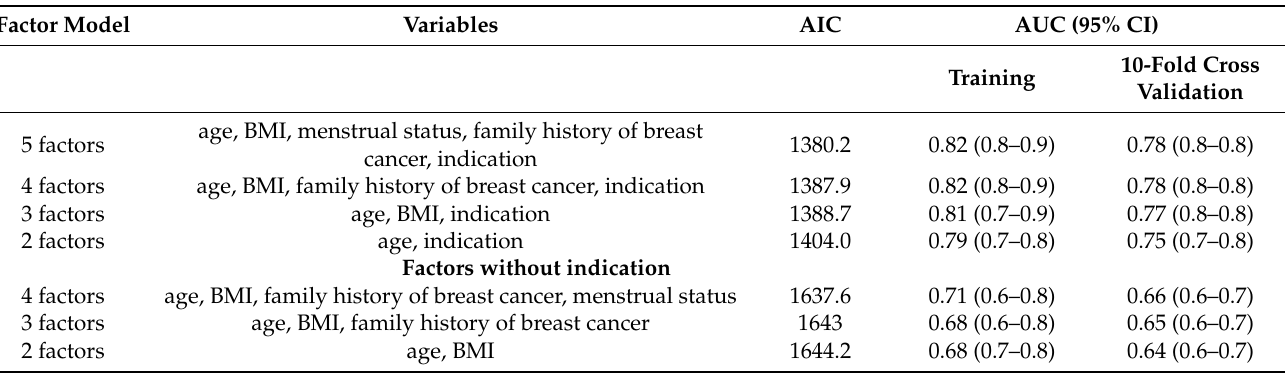
Figure 2. The 4-factor model using age ≥ 50 years, body mass index ≥ 30 kg/m 2 , history of breast cancer in the family, and symptomatic indication for mammography with an Akaike information criterion (AIC) of 1387.9 and areas under the receiver operating characteristic curve of 0.82 (95% confidence interval (CI): 0.77–0.87) and 0.78 (95% CI: 0.77–0.80) from the training dataset and 10-fold cross-validation, respectively. The 2-factor model using age ≥ 50 years and symptomatic indication for mammography, with an AIC of 1404 and areas under the receiver operating characteristic curve of 0.79 (95% CI: 0.74–0.84) and 0.75 (95% CI: 0.74–0.77) from the training dataset and 10-fold cross-validation, respectively. Table 4. Comparing Akaike information criterion and area under the receiver operating characteristic curve values of models with varying factors.